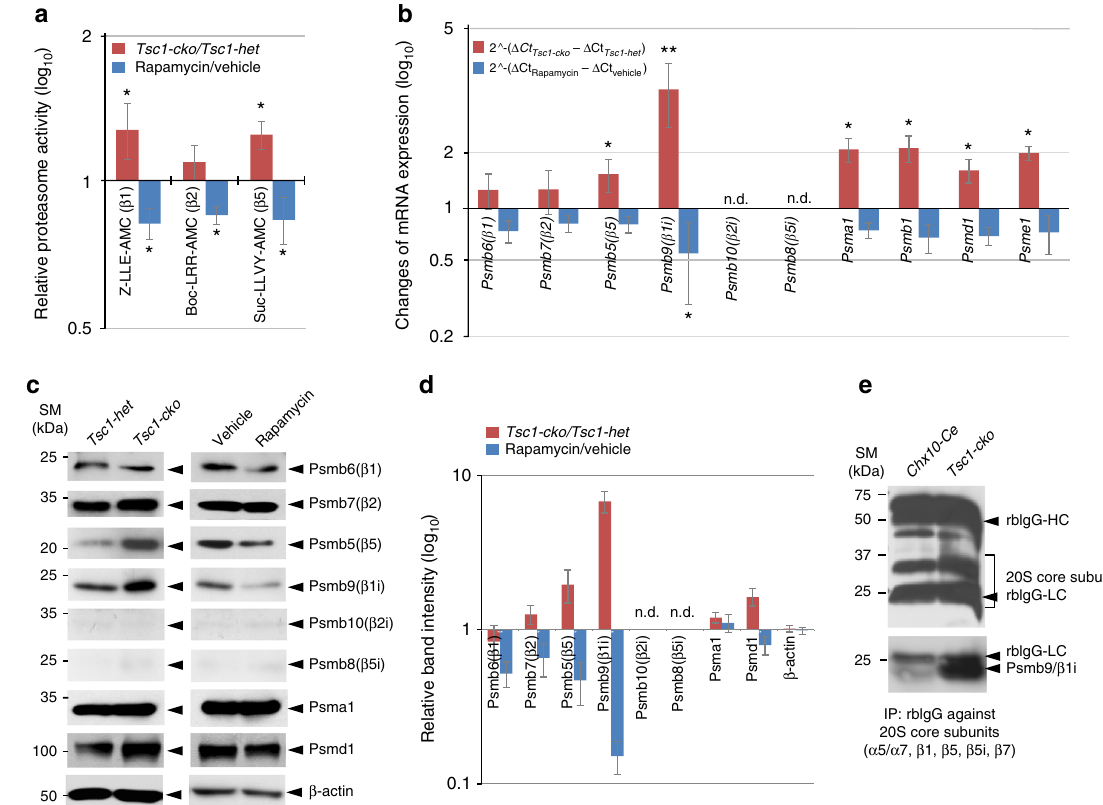
Fig. 6 mTORC1-induced developmental acceleration of the retina requires an immunoproteasome subunit Psmb9. a The 20S proteasomes were puri fi ed from E14.5 Tsc1-het and Tsc1-cko littermate mouse retinas by 20S Proteasome Puri fi cation Kit ® (Enzo Life Sciences), and caspase-like ( β 1/ β 1i), trypsin-like ( β 2/ β 2i), and chymotrypsin-like ( β 5/ β 5i) activities of the puri fi ed proteasomes were analyzed by measuring fl uorescent intensities produced by cleaved peptide substrates Z-LLE-AMC ( β 1/ β 1i), Bz-VGF-AMC ( β 2/ β 2i), and Scu-LLVY-AMC ( β 5/ β 5i) (see details in Methods). The values are averages and error bars denote SD ( n = 3; 3 independent litters). b Relative mRNA levels of 20S proteasome subunits in E14.5 Tsc1-cko and rapamycin-treated mouse retinas were obtained by comparing real-time quantitative PCR (RT-qPCR) values with those of Tsc1-het and vehicle-treated mouse retinas at the same age. The values are averages obtained by 6 ( Tsc1-cko / Tsc1-het ) and 7 (rapamycin/vehicle) independent measurements with mRNA isolated from 4 ( Tsc1-cko / Tsc1- het ) and 6 (rapamycin/vehicle) independent batches. c Relative levels of 20S proteasome subunit proteins in the mouse retinas were also examined by WB with corresponding antibodies. d Image pixels of WB bands in Tsc1-cko samples were calculated by the ImageJ software and relative intensities were obtained by comparing the pixel numbers with those Tsc1-het samples. Values are average measurements of 4 independent WB results. e Incorporation of Psmb9 into the proteasome was examined by WB detection of Psmb9 in 20S proteasome core complex, which was isolated by the 20S Proteasome Puri fi cation Kit. P -values are obtained by Student ’ s t -test and shown in the graphs (*<0.05;